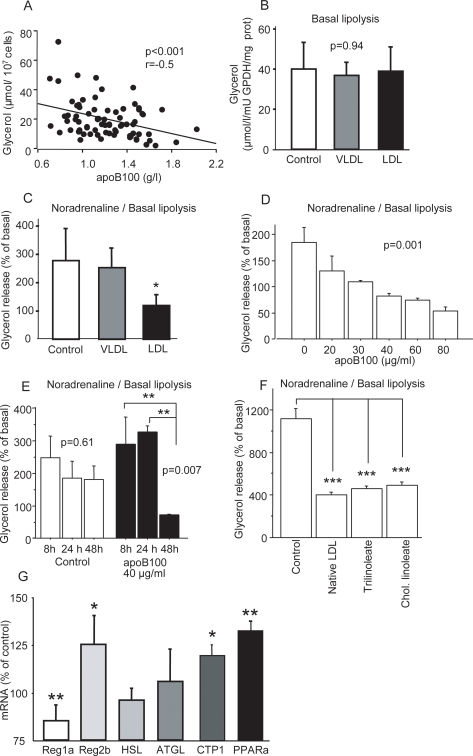
Effects of apoB100, VLDL, and LDL on lipolysis in human fat cells.(A) Linear regression plot of fat cell lipolysis (glycerol release) and plasma apoB100 levels in 48 overweight but healthy men. The linear regression r-value = −0.5, p<0.001. (B) Basal (n = 9; p = 0.94; DF = 2,24; F-value = 0.065) and (C) noradrenaline-stimulated (noradrenaline/basal) (n = 9; p<0.05; DF = 2,24; F-value = 3.6) lipolysis in human differentiated pre-adipocytes incubated with equal concentrations (40 µg apoB100/ml medium) of human VLDL or LDL or with vehicle alone for 48 hours. (D) Inhibition of lipolysis in human differentiated pre-adipocytes incubated without or with human LDL at five concentrations (20, 30, 40, 60, 80 µg apoB100/ml medium) for 48 hours (n = 3 for each concentration; p = 0.001; DF = 2,5,10; F-value = 10.4) and (E) with different incubation times (8, 24 and 48 hours) with 40 µg apoB100/ml medium (n = 5 for each time point; DF = 2,12) p = 0.61; F-value = 0.48 for vehicle and p = 0.007; F-value = 7.6 for apoB100 incubation. (F) Noradrenaline-stimulated (noradrenaline/basal) lipolysis in human differentiated pre-adipocytes incubated with vehicle alone, native LDL and two forms of reconstituted LDL (40 µg apoB100/ml medium) for 48 hours (n = 29–34 in each group). “Trilinoleate” indicates reconstituted LDL in which cholesterol esters had been replaced with Trilinoleate. “Chol. linoleate” indicates reconstituted LDL in which cholesterol esters had been replaced with cholesteryl linoleate. (G) mRNA expression (n = 4–8) in human differentiated pre-adipocytes incubated with human LDL (40 µg apoB100/ml medium) presented as % of control cells (not exposed to LDL). Error bars in (B,C,G) indicate SD and in (D,E,F) indicate SE. p-values for (B, C, D, E) were determined by ANOVA and for (F,G) un paired t-test. *p<0.05, **p<0.01, ***p<0.001 indicate Fisher's Post-hoc test.